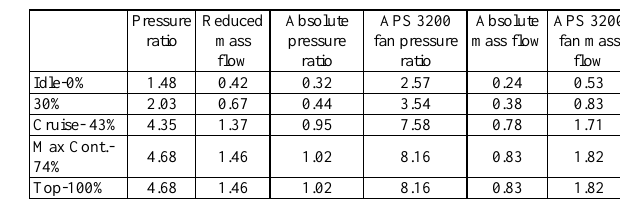
Table 17. Parameter of APS 3200 V = 0.2 Ma, H = 2000 m